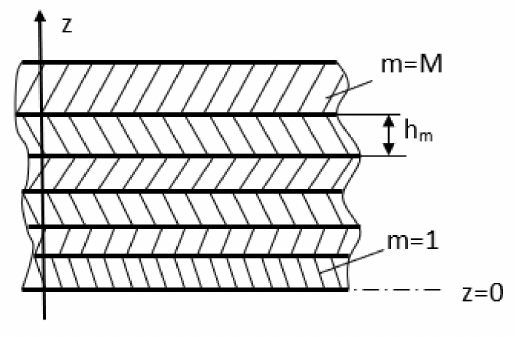
Figure 3. Multi-layer structure